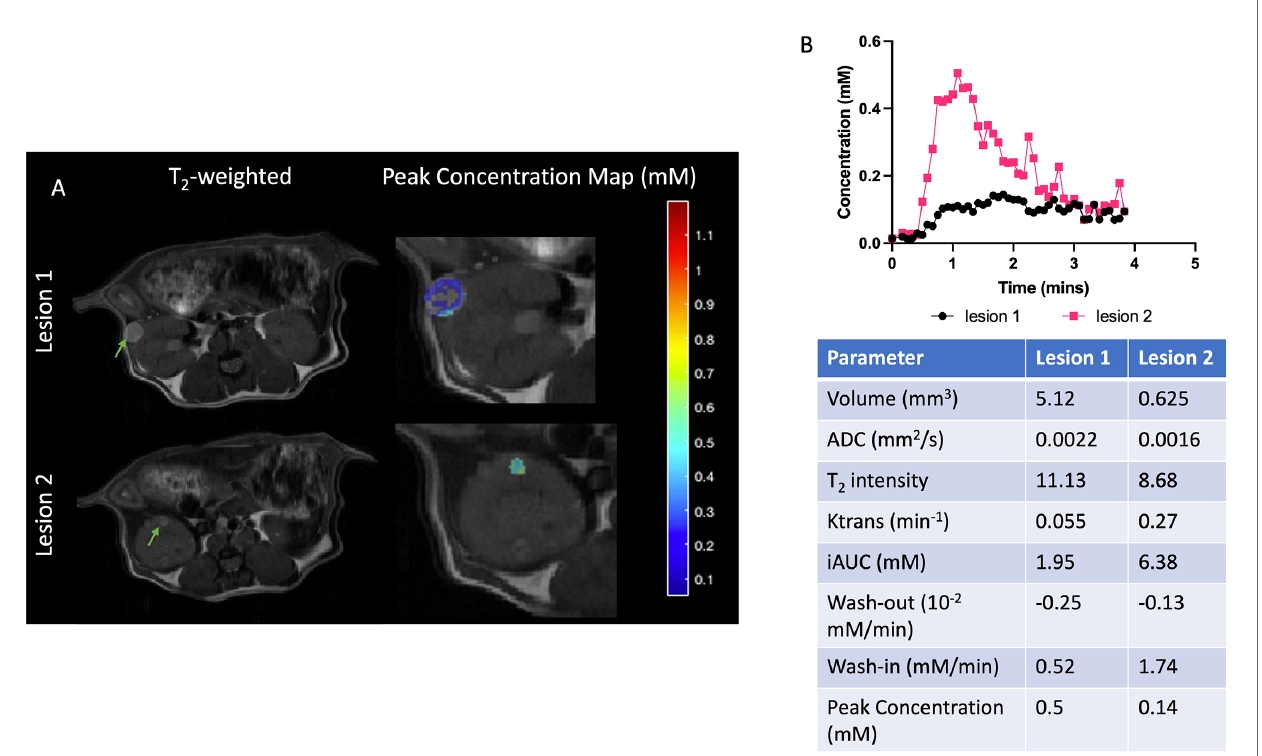
FIGURE 3 | Representative cystic and cellular lesions and their baseline properties. (A) Representative T 2 -weighted and magnevist peak concentration maps. (B) Dynamic curves of magnevist concentration from two lesions. Table with physiological and DCE parameters for the lesions. Lesions are indicated with green